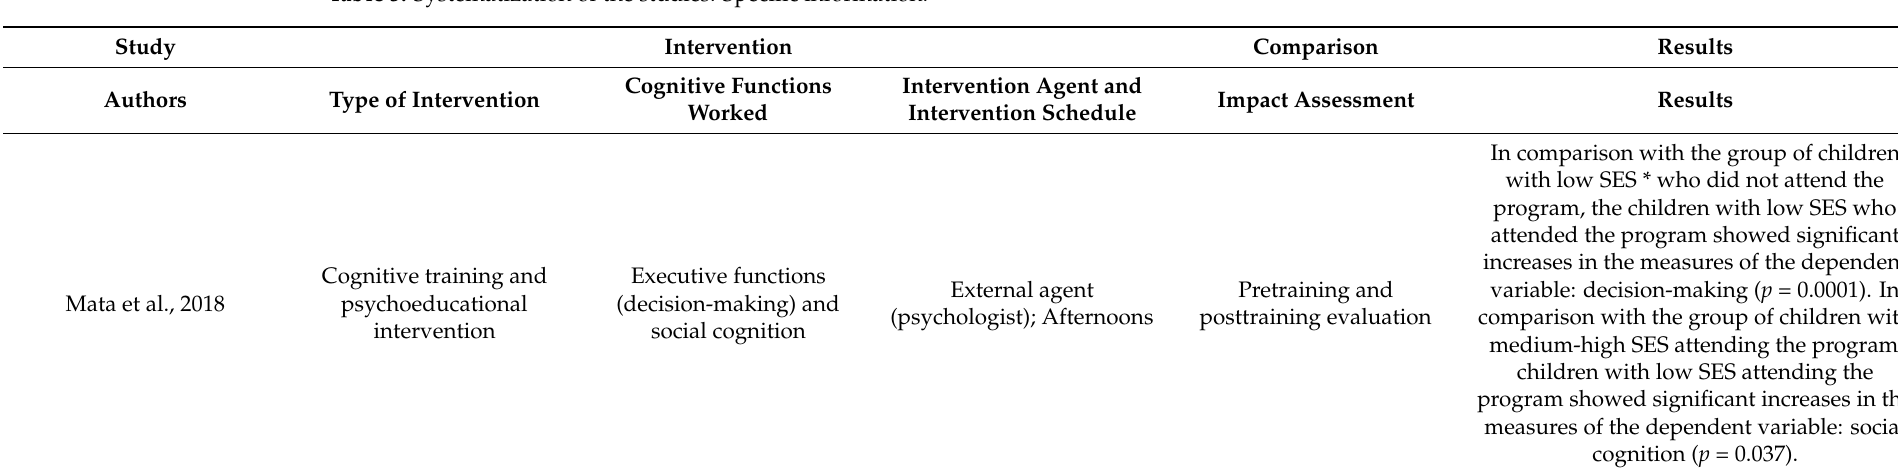
Table 3. Systematization of the studies: Specific